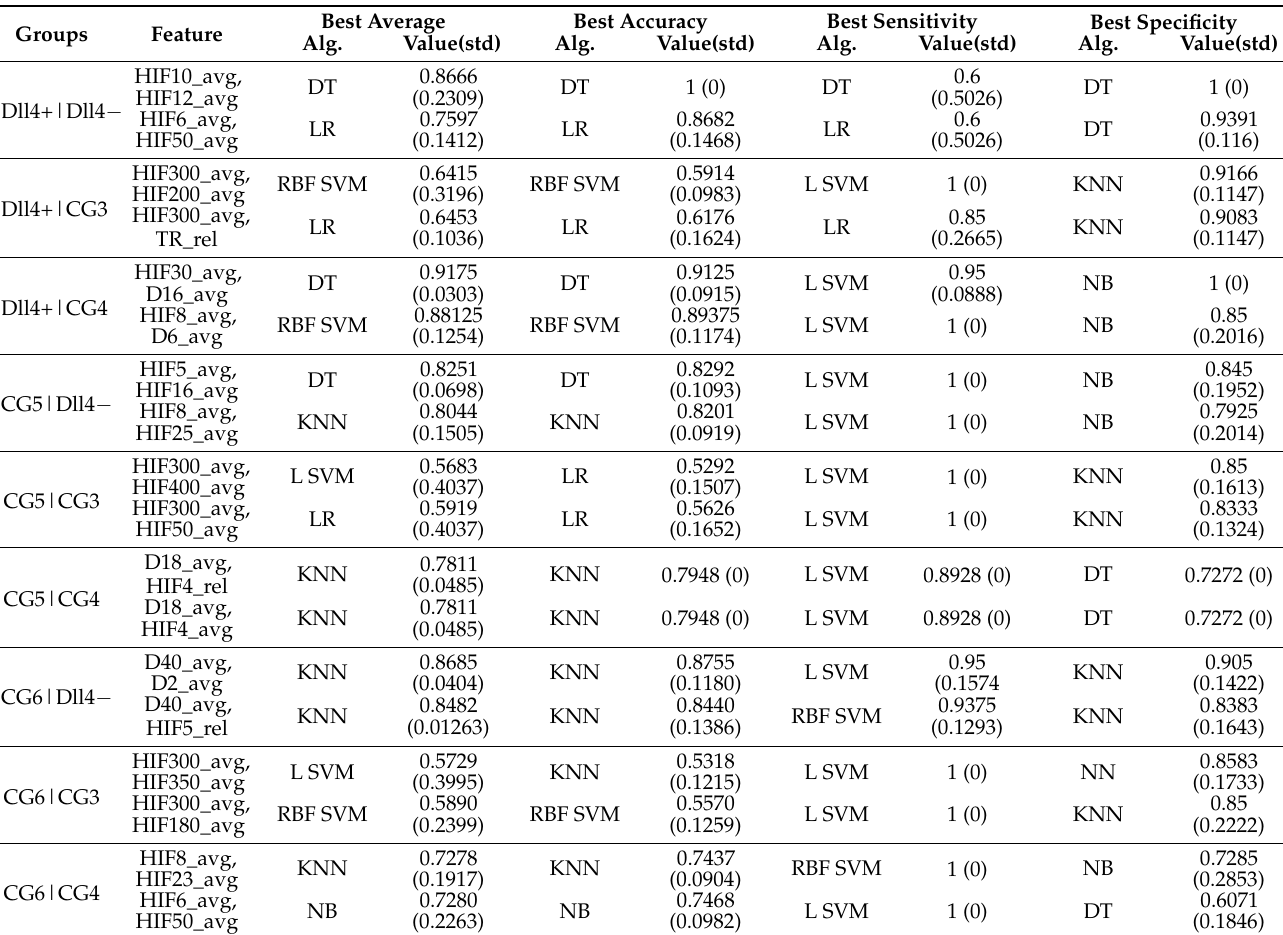
Table 2. Primary validation and feature